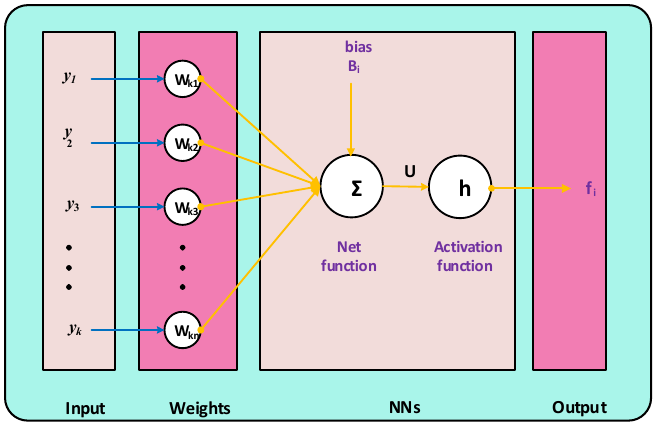
Figure 2. Structure of a single neuron based on the ANNs-LMB.